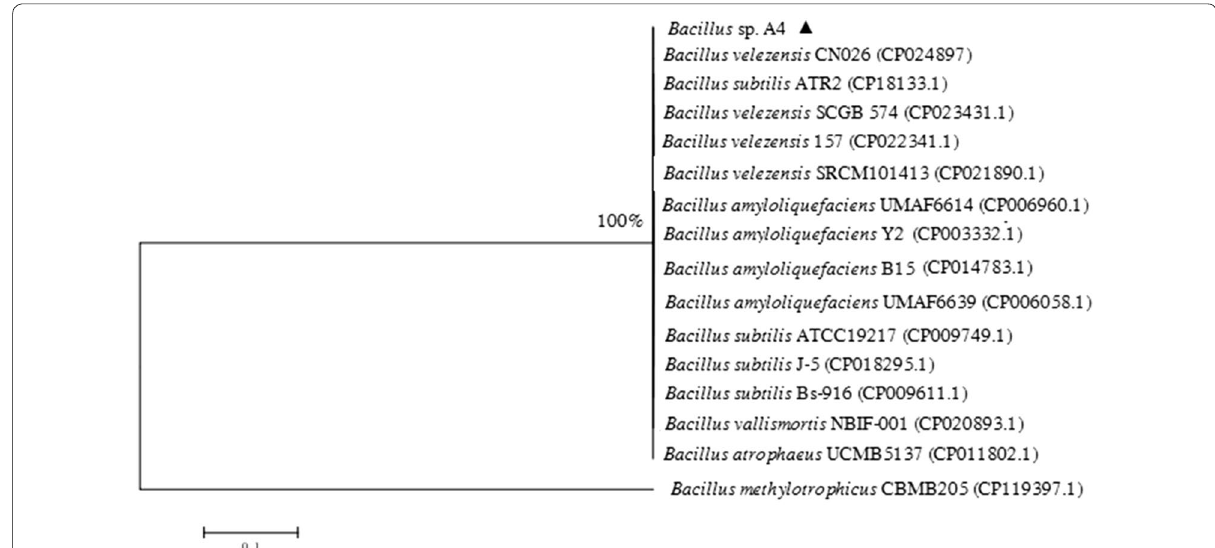
Fig. 2 Phylogenetic tree was constructed by neighbor-joining method using rpoB gene sequence obtained from different Bacillus strains in GenBank. The numbers at the branches indicate the confidence level calculated by bootstrap analysis (1000). The scale bar shows the evolutionary distance between species. The numbers in the brackets are the accession numbers of rpoB gene sequences from